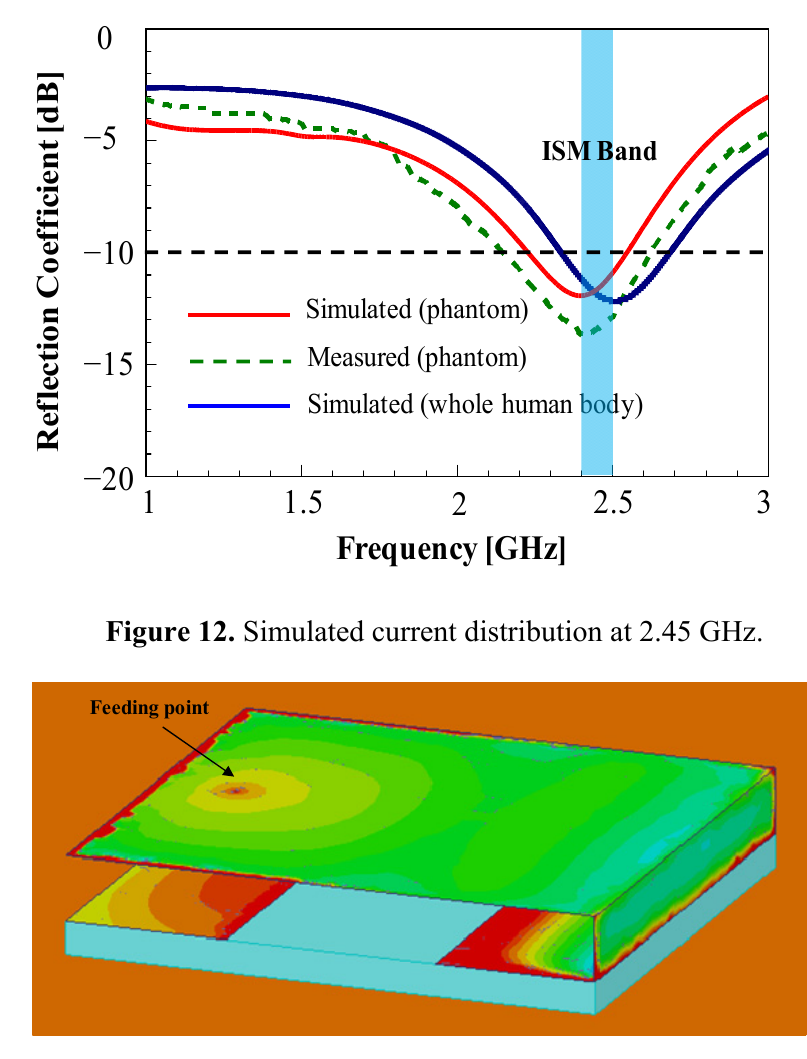
Figure 11. Simulated and measured reflection coefficients.